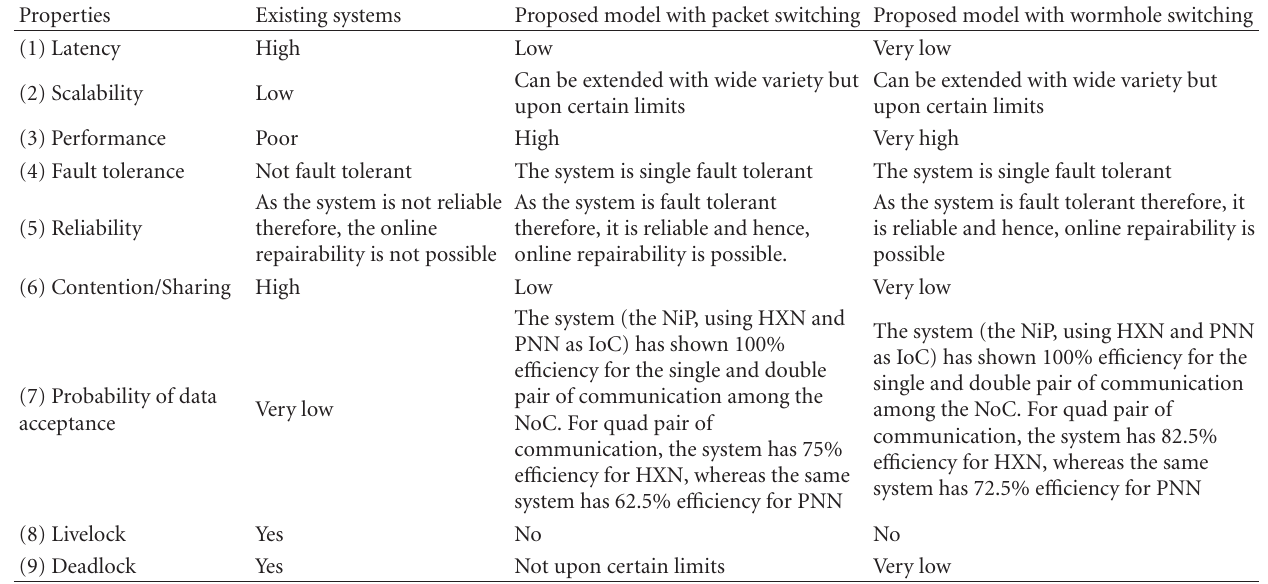
Table 28: The comparison of the existing and proposed parallel communication